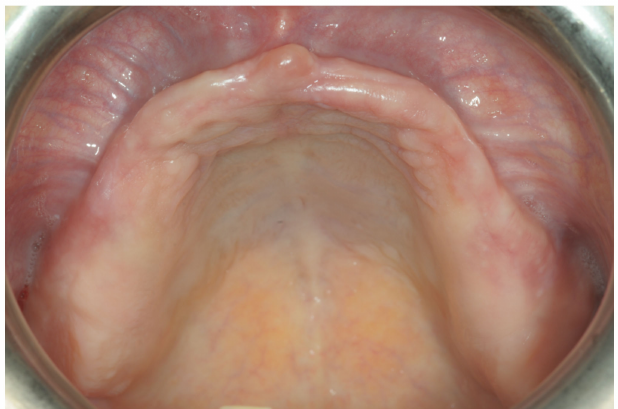
Figure 2. Sequence of treatment phase of the only patient who was treated according a 2-stage approach: stage 1 GBR procedure and stage 2 implant placement (pre-operative